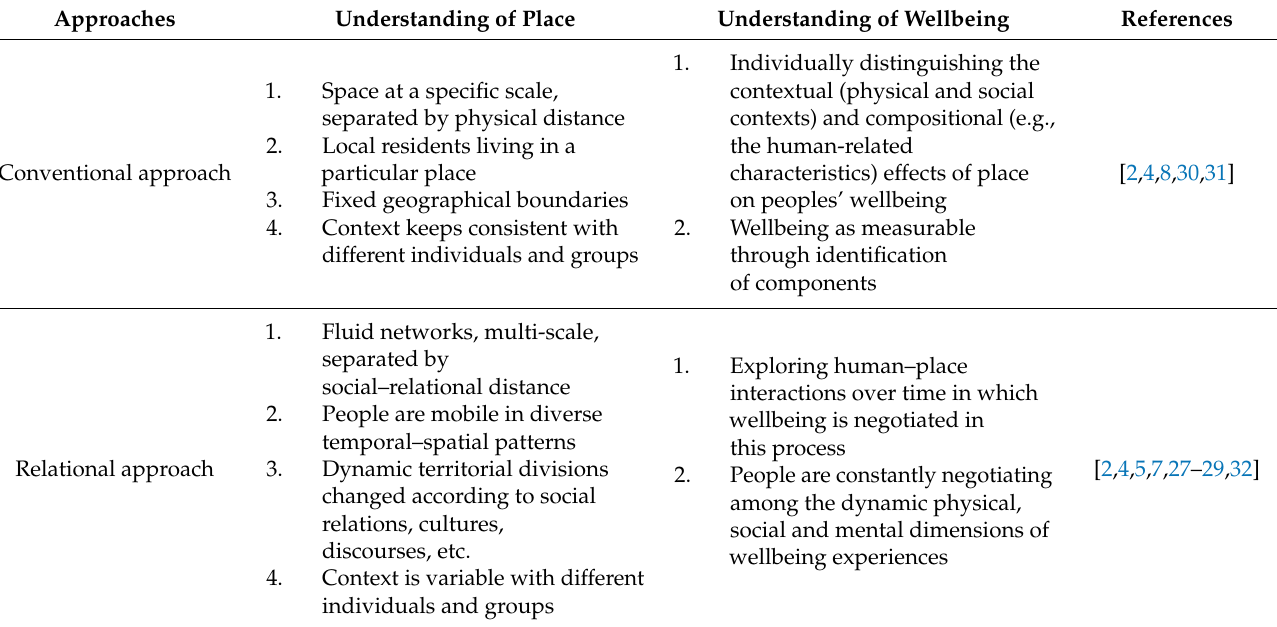
Table 1. Conventional and relational perspectives of place and place-based